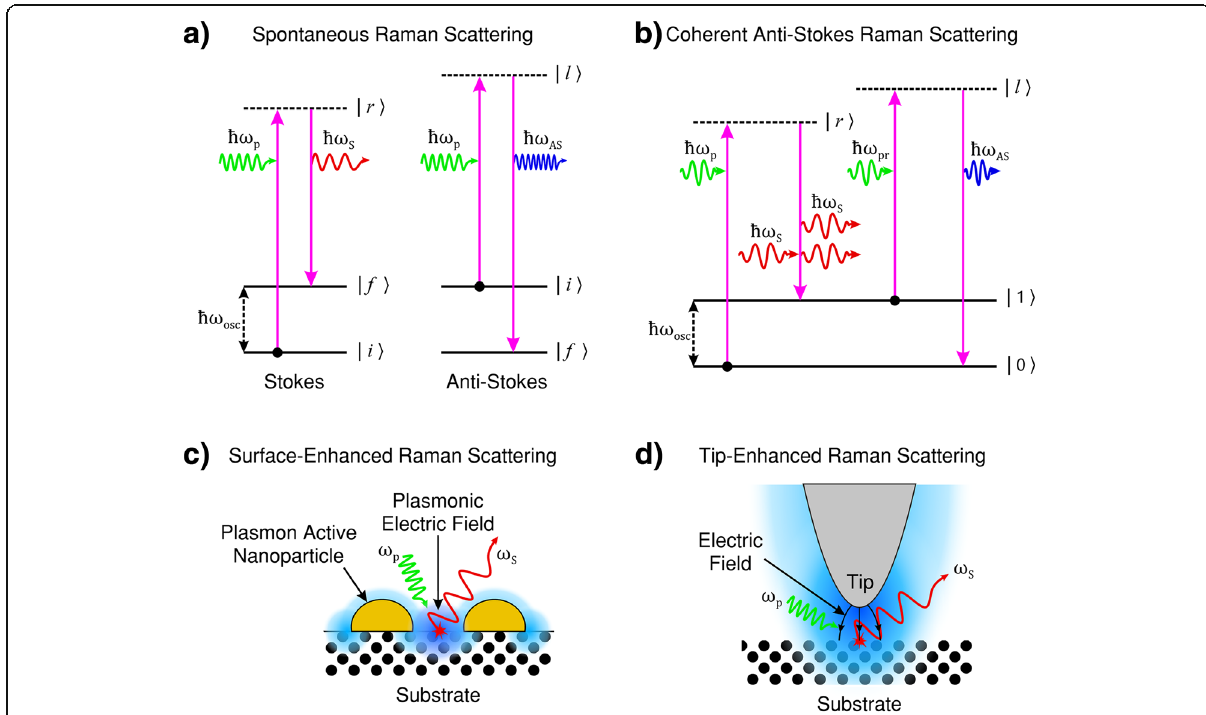
Fig. 1 a Energy transfer process in Stokes (left) and anti-Stokes (right) Raman scattering, in both scattering processes, the lifetime of the excited state is probabilistic and spontaneous. In Stokes Raman scattering, the initial (ro-)vibrational energy |i 〉 of the scattering material is less than that of the final state |f 〉 , the scattered light has less energy than the pump light. In anti-Stokes scattering, the initial (ro-)vibrational energy |i 〉 of the scattering medium is greater than that of the final state |f 〉 , the scattered light has more energy than the pump light. b Coherent anti-Stokes Raman scattering (CARS). CARS is a four-wave mixing process of pump, Stokes, probe and anti-Stokes light in which the emission of anti-Stokes light is coherently induced through an intermediate (ro-)vibrational energy state population inversion. c Surface-enhanced Raman scattering (SERS). The incident pump light induces a surface plasmon resonance. The resultant enhancement of the oscillatory electro-magnetic (EM) field strength (shown in blue) on the surface intensifies the light-matter interaction and consequently increases the intensity of the Raman scattered light. d Tip-enhanced Raman scattering (TERS). The incident pump light induces a tip-surface plasmon resonance associated with the plasmonically active tip. The resultant enhancement of the oscillatory EM field strength (shown in blue) is localised to the vicinity of the tip apex. The lighting rod effect (illustrated by curved black arrows) intensifies the light-matter interaction in the tip region and provides high-resolution (beyond the diffraction limit of light) Raman imaging. a , b adapted from [1]. c adapted from [111]. d adapted from